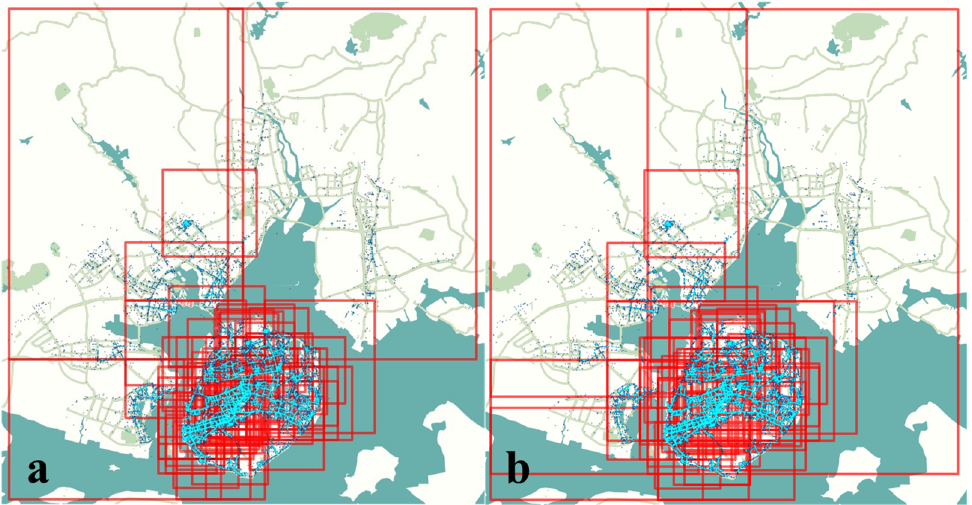
Figure 10. Data partition map. ( a ) Final spatial partition result of Hilbert curve, ( b ) Final spatial partition result of Z-curve.